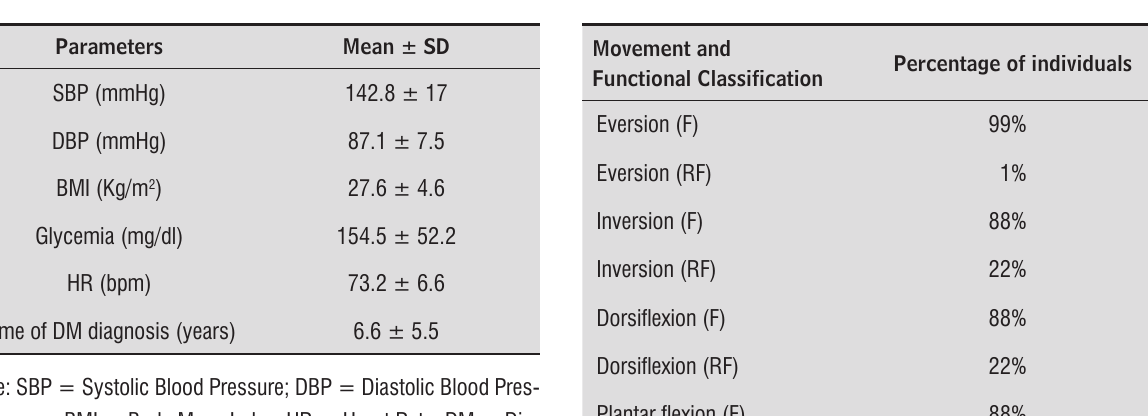
Table 1 - Mean and standard deviation values of clinical and anthropometric parameters